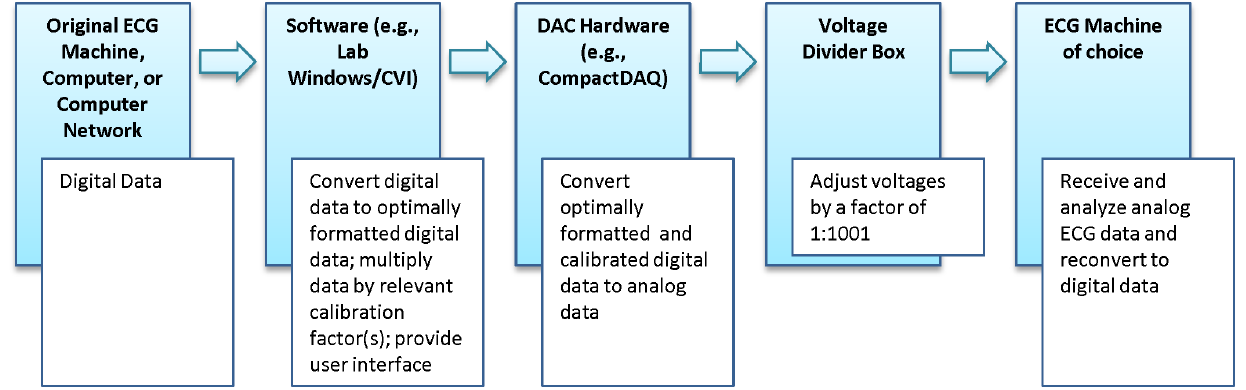
Figure 2. Schematic summarizing all stages of ECG data processing by the system.